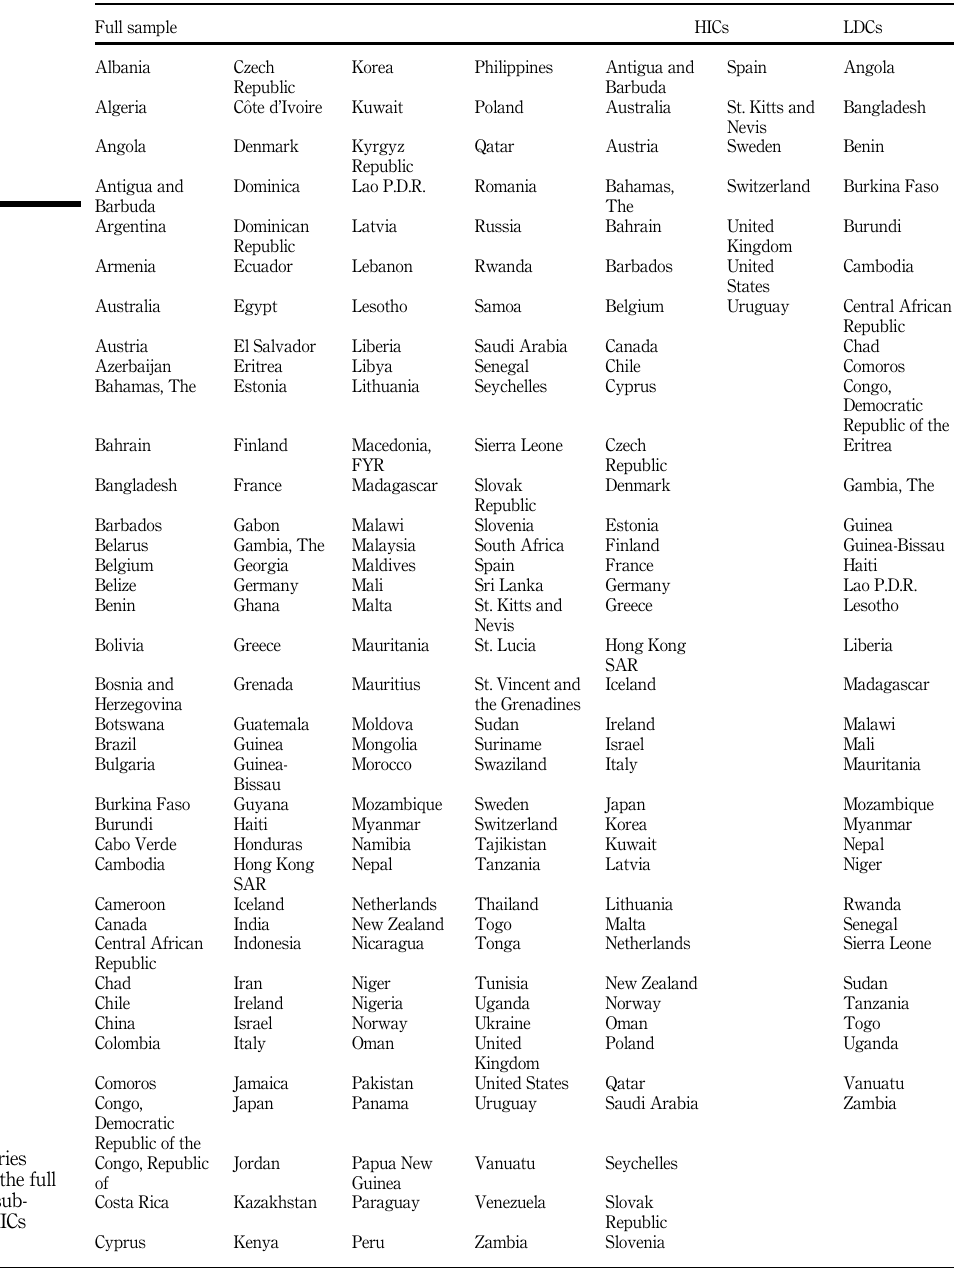
Table A3. List of countries contained in the full sample and sub- samples of HICs and